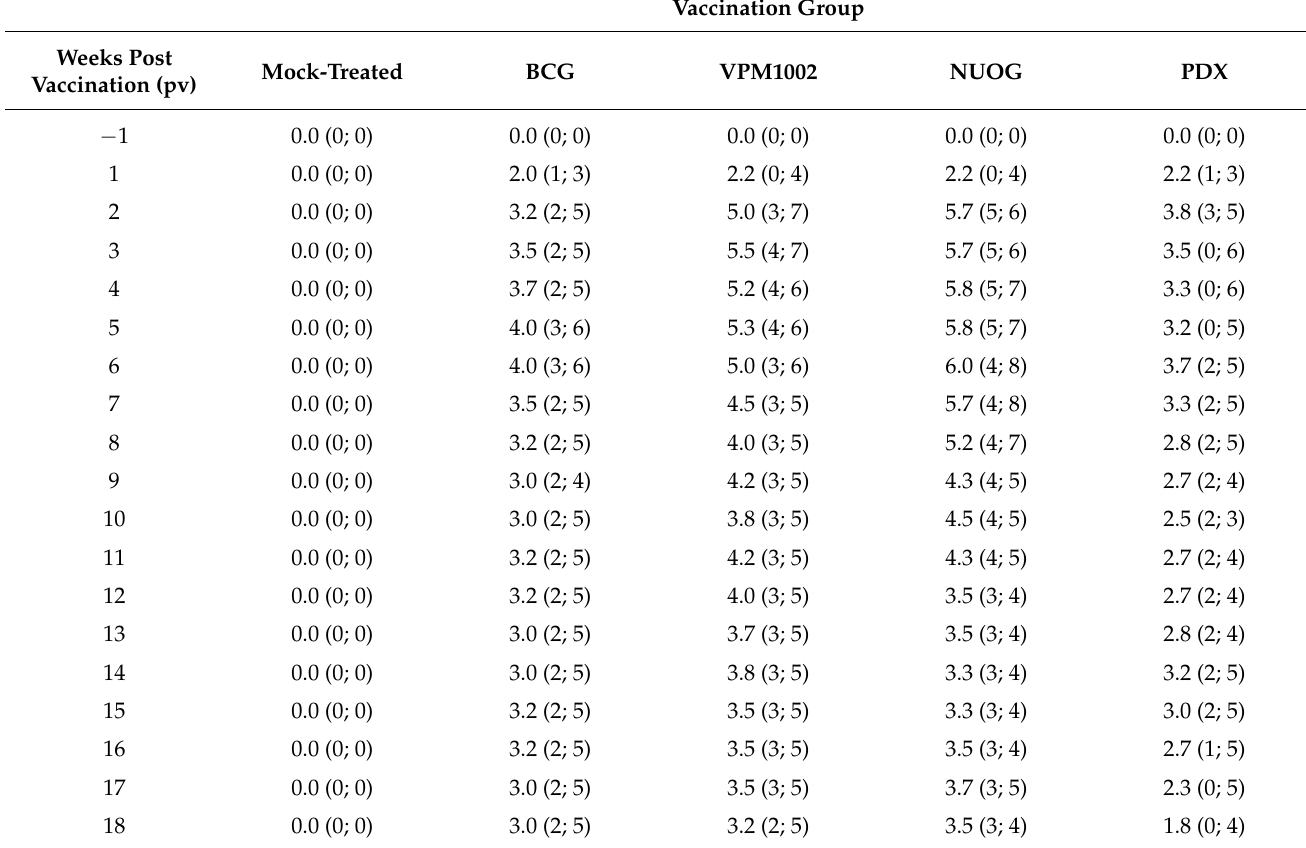
Table 1. Skin lesions at the injection site of goats vaccinated with vaccine strains BCG, VPM1002, NUOG, PDX, or mock-treated. Mean (minimum; maximum) values of a total score per animal group ( n = 6) are indicated. The total score describes the sum of the values for the size of lesion, redness, pain, swelling, local temperature, and necrosis (0 = no reaction, 1–4 = mild symptoms, 4–8 = moderate